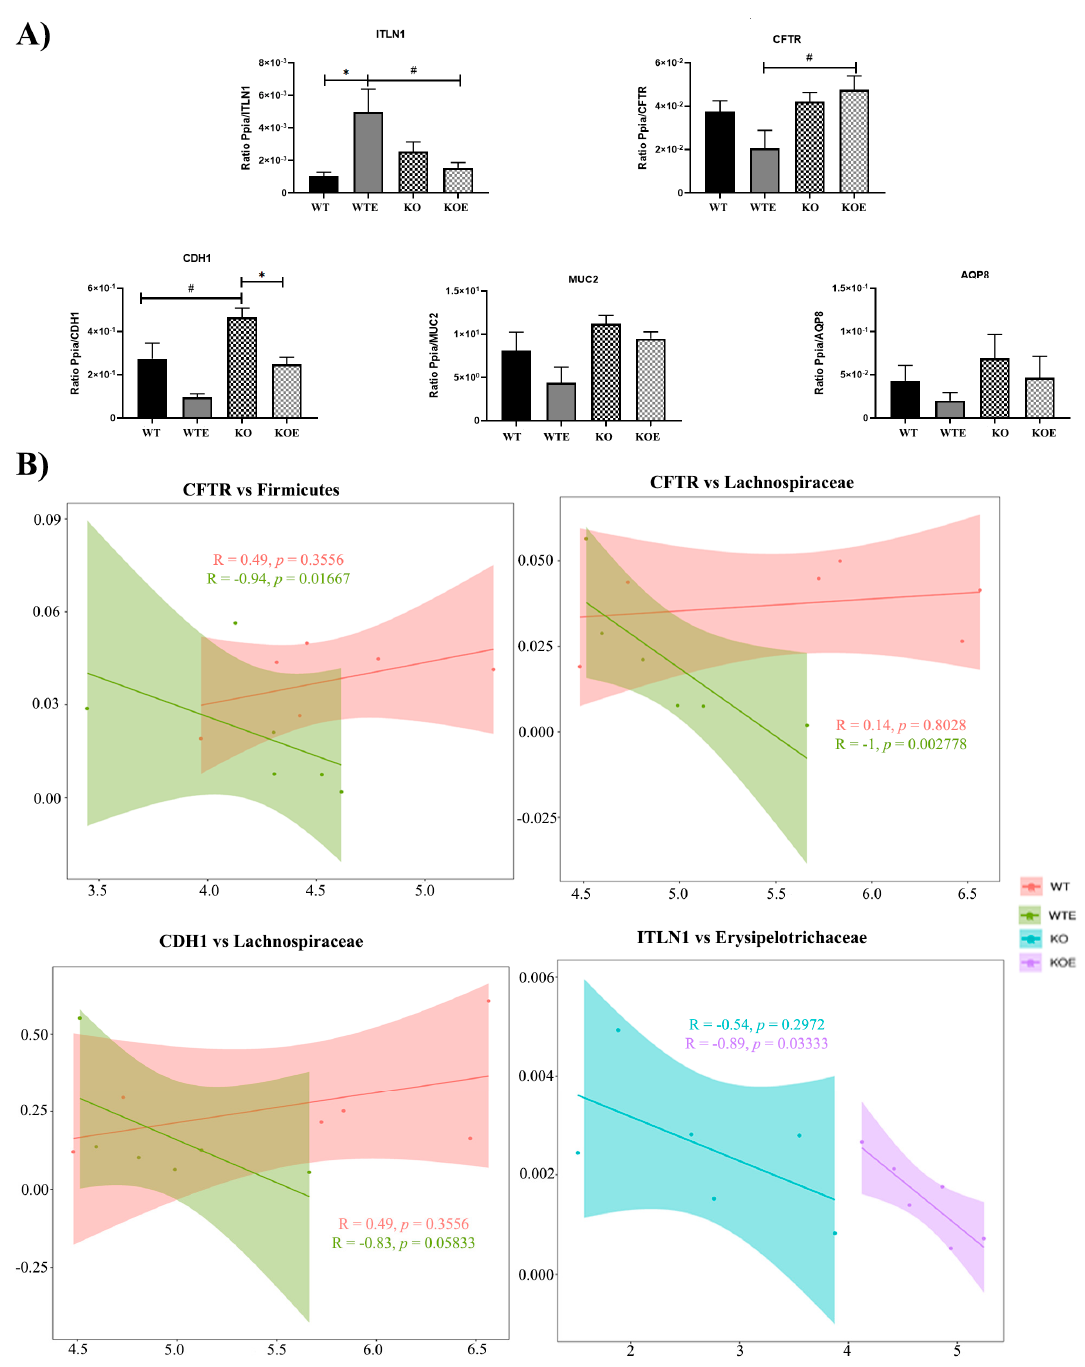
Figure 7. RT-qPCR differential expression analysis and gene–bacteria correlations. ( A ) The graphics represent the RT-qPCR comparisons made from the colons of the WT and TLR4-KO mice, with and without ethanol treatment. Colon expression of the lectin ITNL1, protein CFTR, cadherin CDH1, mucin 2, and aquaporin 8 mRNA levels. * p < 0.05 for treatment comparison, and # p < 0.05 for genotype comparison according to one-way ANOVA and Tukey’s multiple comparisons test, except for MUC2 and AQP8, according to the Kruskal–Wallis test and Dunn´s comparisons test. N = 6. Bars represent the mean ± SEM. ( B ) Scatterplots depicting the correlation analysis between the genes associated with intestine health and gut microbes with differential abundance within groups. The strength of the correlation (Spearman’s rank correlation coefficient) is represented as R ) and significance is represented as p . Both are indicated in each